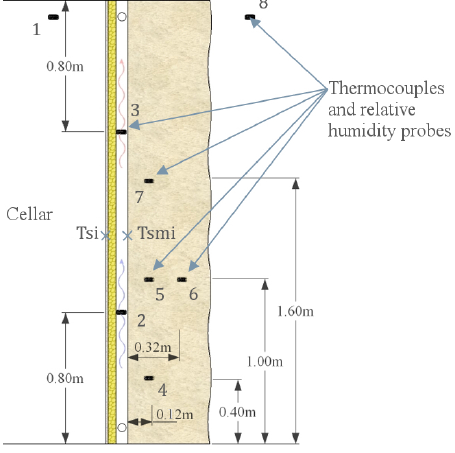
Figure 9. Schematic of the installation of the aeraulic dehumidifying